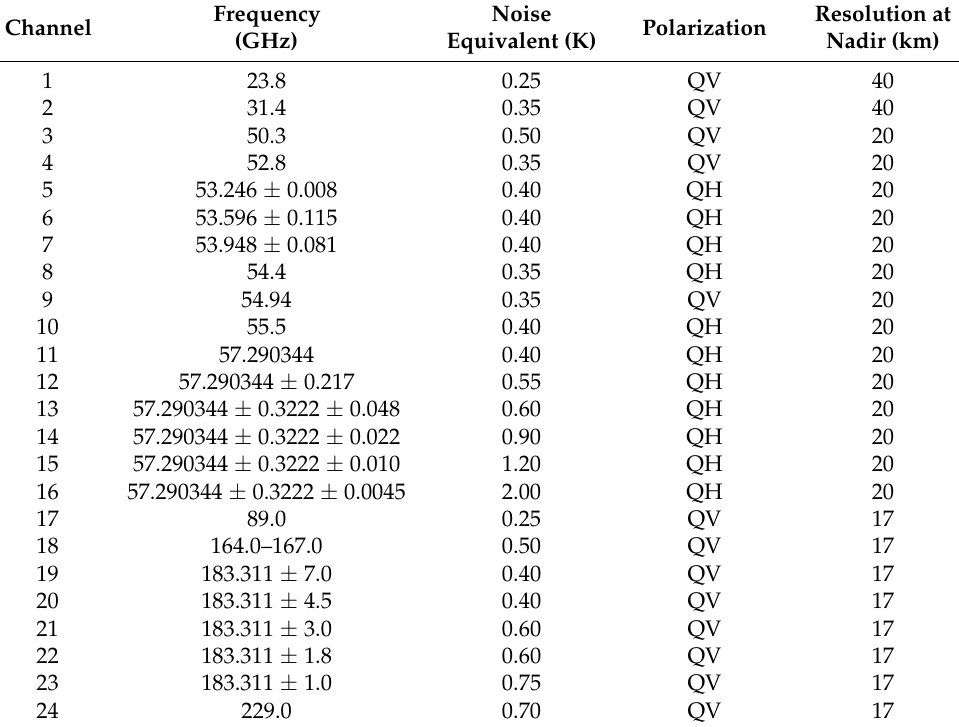
Table 1. List of MWS channels with information on radiometric noise, polarization and spatial resolution.